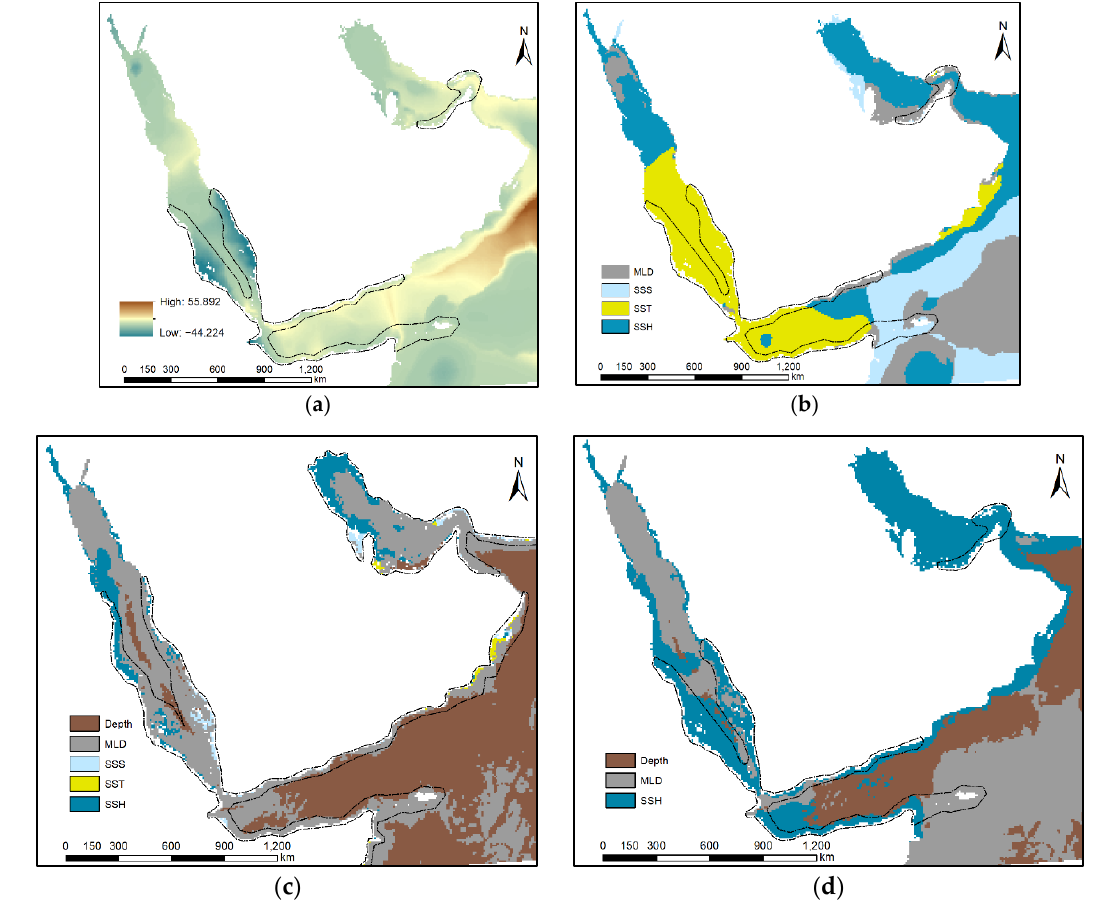
Figure 5. Model exploration maps: ( a ) extrapolation region using multivariate environmental simi- larity surfaces (MESS) analysis showing the extent of extrapolation or similarity of each point to reference points; ( b ) most dissimilar variable (MoD) map showing the smallest similarity at each point; and ( c ) limiting factor (LF) analyses highlighting the most important limiting factors for pre- dicted current and ( d ) future distributions. The black polygons represent the potential future distri- bution range for ( a , b , d ), and ( c ) the potential current distribution range based on Maxent prediction. Depth (sea floor depth, m), MLD (mixed layer thickness, m), SSS (sea surface salinity, ppt), SST (sea surface temperature, °C), and SSH (sea surface height, m). (See text for details). 4. Discussion 4.1. Predicted Suitability and Re/Colonization The current model predicted large areas of high suitability in the Arabian Gulf. This region was expected to be highly suitable, as it currently supports the largest portion of the bird population. Unexpectedly, the model predicted large patches of highly suitable areas in the southern Red Sea region with an overall suitable area that exceeded the pre- diction in the Arabian Gulf by 7300 km 2 . Some islands in this region were historically used, although there are limited studies on the species from the region [8,14], and there are no up to date breeding records [8]. Historically, there appear to be foraging areas located on either side of the coast of the southern Red Sea. Thus, the suitability predicted by our model highlights historic foraging areas for the species [8]. It must be noted that our model did not include biological variables (e.g., prey fish movement and abundance) due to the lack of these data in the region. However, the variables used as predictors have a strong influence on oceanographic factors, which in turn impact forage fish distributions (dis- cussed further below) [10]. It was also difficult to obtain representative parameters for the future scenarios. In low latitude regions, biotic conditions are thought to play a primary role in determining distributional limits [58]. Modelling a species distribution and its re- lationship with environmental variables is an iterative process, where further testing and validation takes place [59]. Since our model was restricted to marine physical data, the outcomes of the modeling should be tested in an iterative manner using additional sam- pling, validating, and re-modeling. Several other variables can affect the distribution of seabirds, including predation, competition, prey abundance, genetic diversity, adaptation, evolution, and the ability to disperse [59]. There are no studies on Socotra Cormorants that extensively investigated their movement between colonies or how they respond to changes in their islands and marine foraging ground status. Khan et al. [22] reported that Socotra Cormorants were able to relocate to inactive colonies and colonize new areas, as seen in the cases of Ghagha, Bu Tinah, and Digala Islands off the western Abu Dhabi emirate coast. However, the prox- imity between these islands and the surrounding active colonies were ≤150 km. These three colonies showed low disturbance levels, and two of them (Ghagha and Bu Tinah)